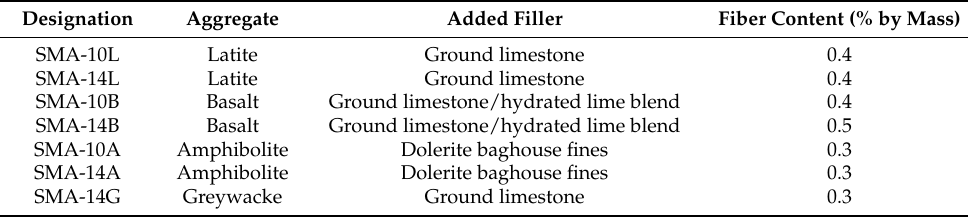
Table 6. SMA mixture designations and